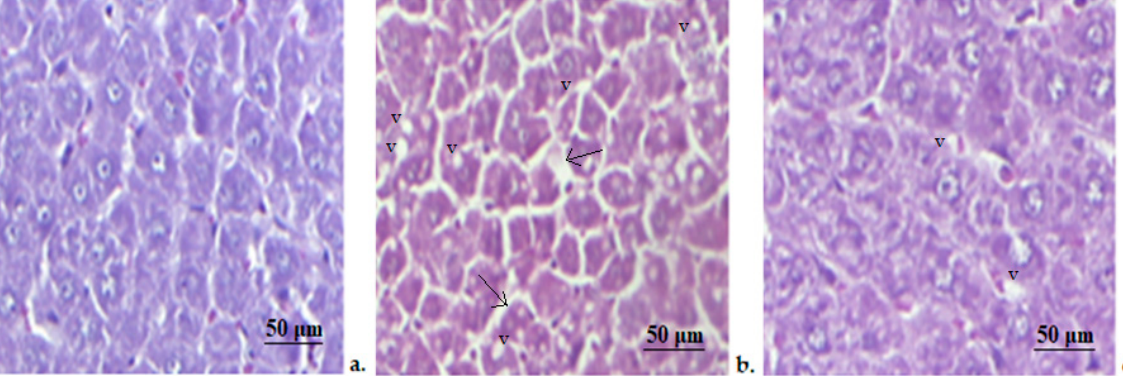
Figure 4. Liver histopathologic exam. ( a ) Control group; ( b ) STZ group; ( c ) STZ+Zn group. (v—vacuoles). Masson trichrome stain × 20.